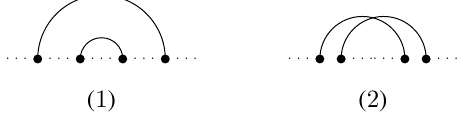
Fig. 3: The two forbidden configurations in the matching of an involution σ ∈ DI irr 2 n (321)